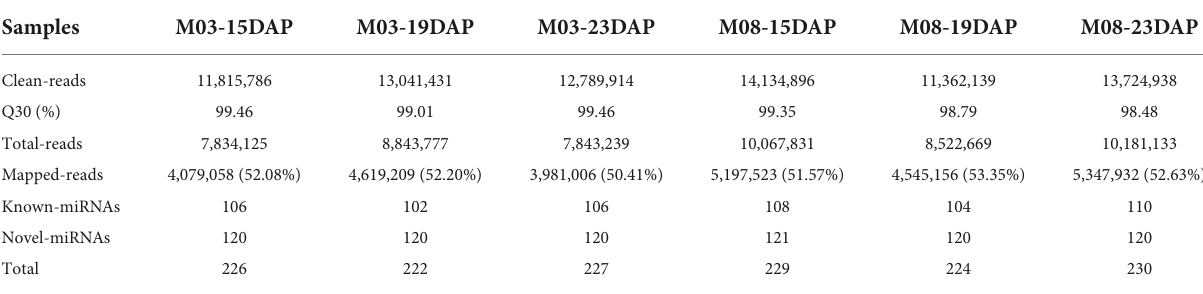
TABLE 2 Summary of miRNA sequencing